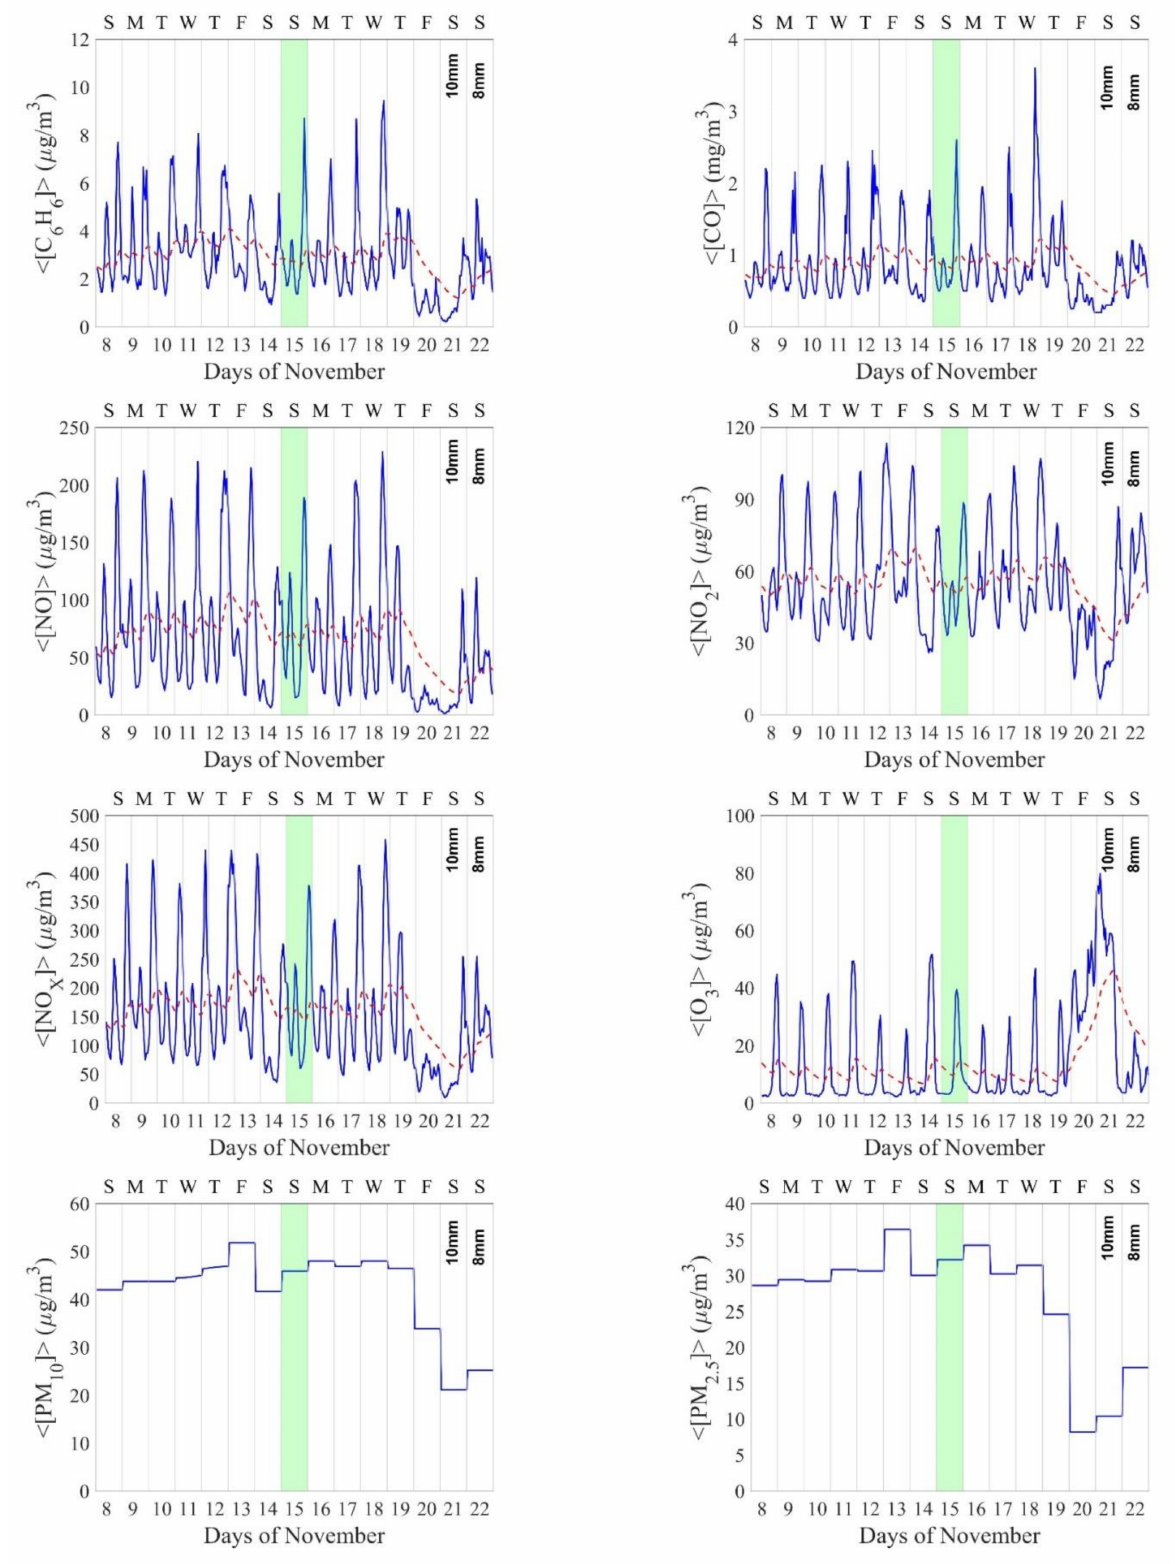
Figure 7. Pollutant concentration variation related to the total block of urban traffic of 15th November 2015 (green band). The blue line is the hourly pollutant concentration. The Red dashed line is the daily mean pollutant concentration. Data of daily precipitation are indicated in